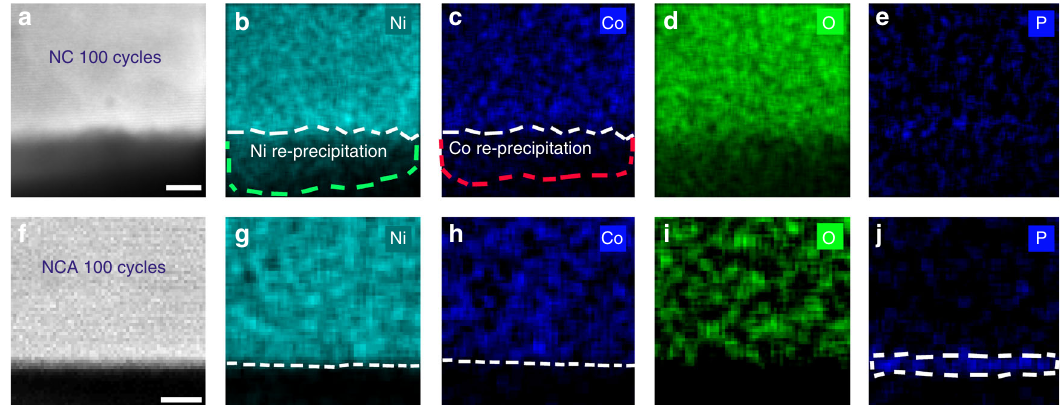
Fig. 5 TM re-precipitation on NC surface and formation of P containing CEI layers in NCA samples. a HAADF-STEM image of NC sample after 100 cycles. b – e EDS mapping of Ni, Co, O, and P, respectively, from the region in a . The white lines outline the boundary of parent NC phase, and the green and red dashed lines outline the contour of amorphous Ni, and Co elements, respectively. f HAADF-STEM image of NCA surface after 100 cycles. g – j EDS mapping of Ni, Co, O, and P, respectively, from the region in f . The white lines in g , h , and j outline the boundary of Ni, Co, and P containing CEI layers, respectively. Scale bar, 3 nm ( a ), 4 nm ( f